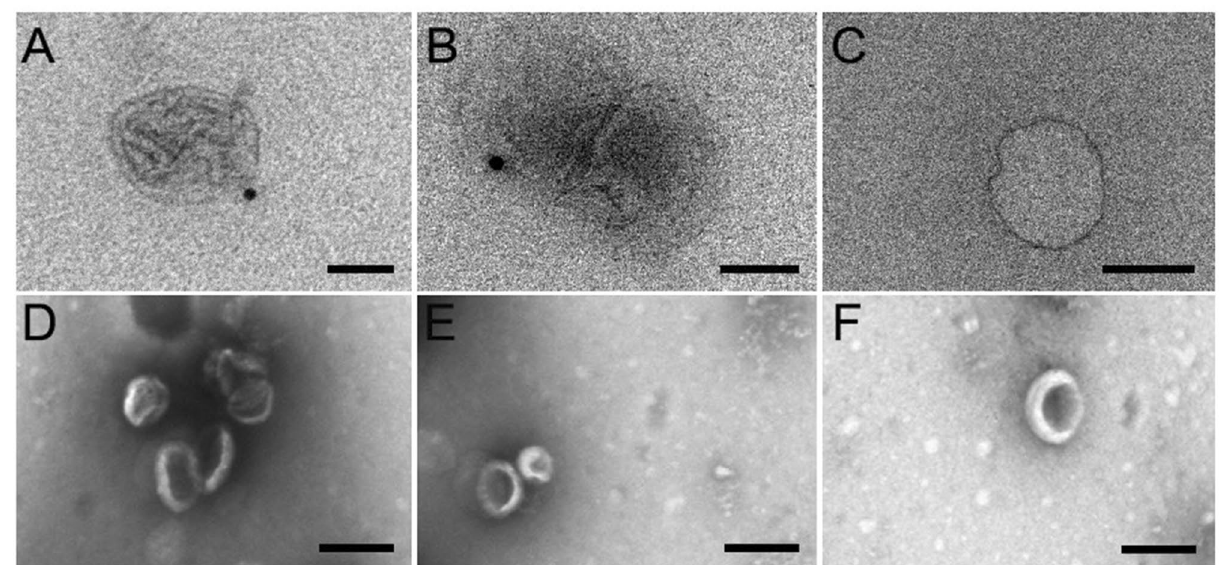
Figure 3. TEM and SEM analysis of EV populations isolated from hiPSC-derived 3D retinal organoids. ( A–C ) Immunogold TEM of EV samples isolated from hiPSC-derived 3D retinal organoids revealed proper localization of exosomal protein CD63 ( A ; scale 100 nm); and microvesicle protein Tsg101 ( B ; scale 100 nm) compared to immunogold TEM control ( C ; scale 100 nm). ( D – F ) SEM imaging of EVs isolated from hiPSC- derived 3D retinal organoids demonstrated characteristic spheroid and cup-shape morphologies, with diameters ranging from approximately 50–200 nm; scale 250